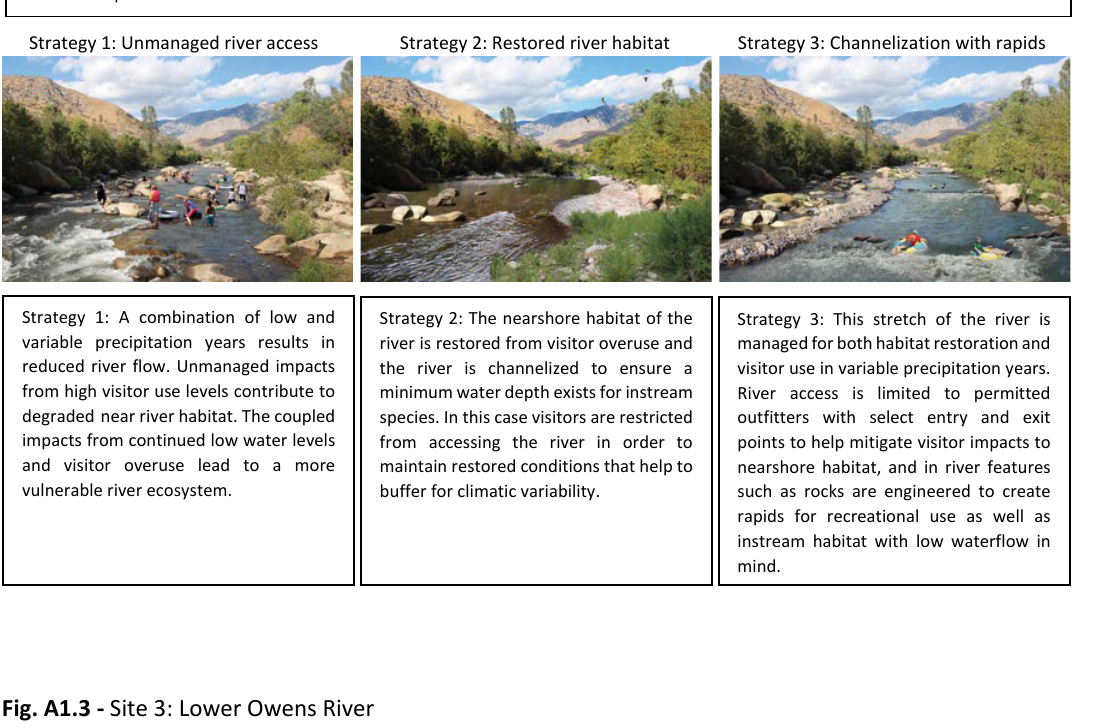
Fig. A1.3 - Site 3: Lower Owens